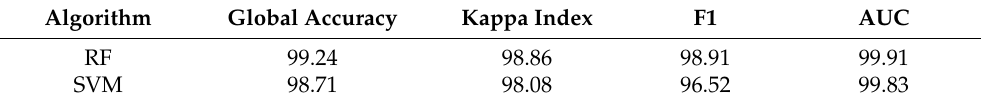
Table 1. Performance metrics for the RF and SVM classification algorithms.